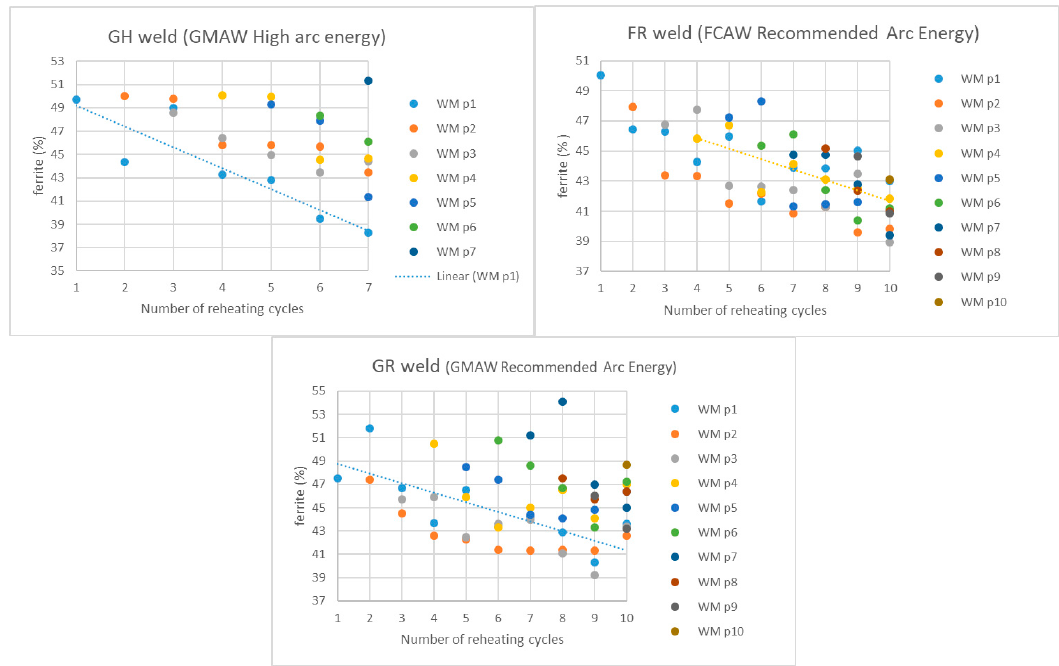
Figure 8. Ferrite content (Y-axis) measured by magnetic permeability pass by pass to evaluate the influence of the successive reheating on the ferrite content. A progressive reduction in ferrite content was observed in the weld metal. For better clarity of the reduction in ferrite, dotted lines show a linear regression of ferrite content in specific weld metal passes (Weld Pass 1 in the GH and GR welds and Weld Pass 4 in the FR weld). “WM pX” means the weld metal deposited in Weld Pass X.